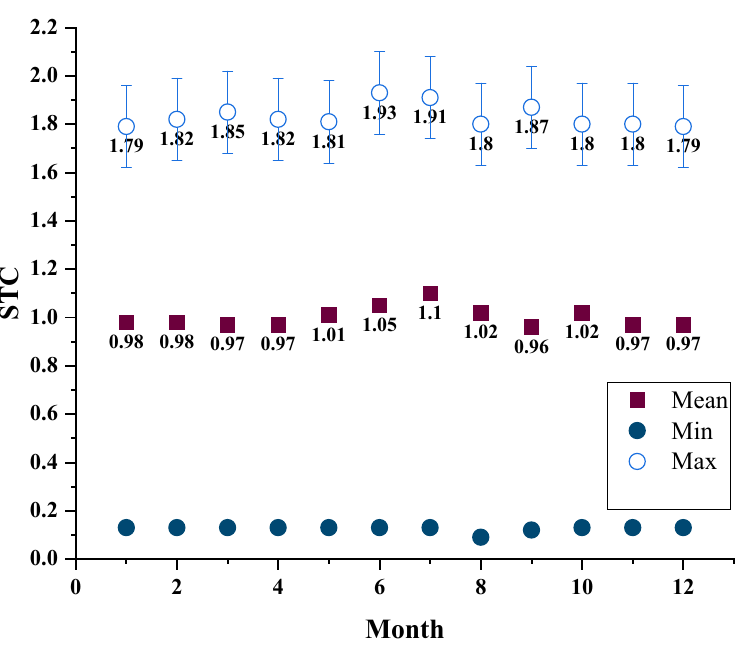
Figure 9. Monthly values of STC on the Qinghai–Tibet Plateau in 2018.